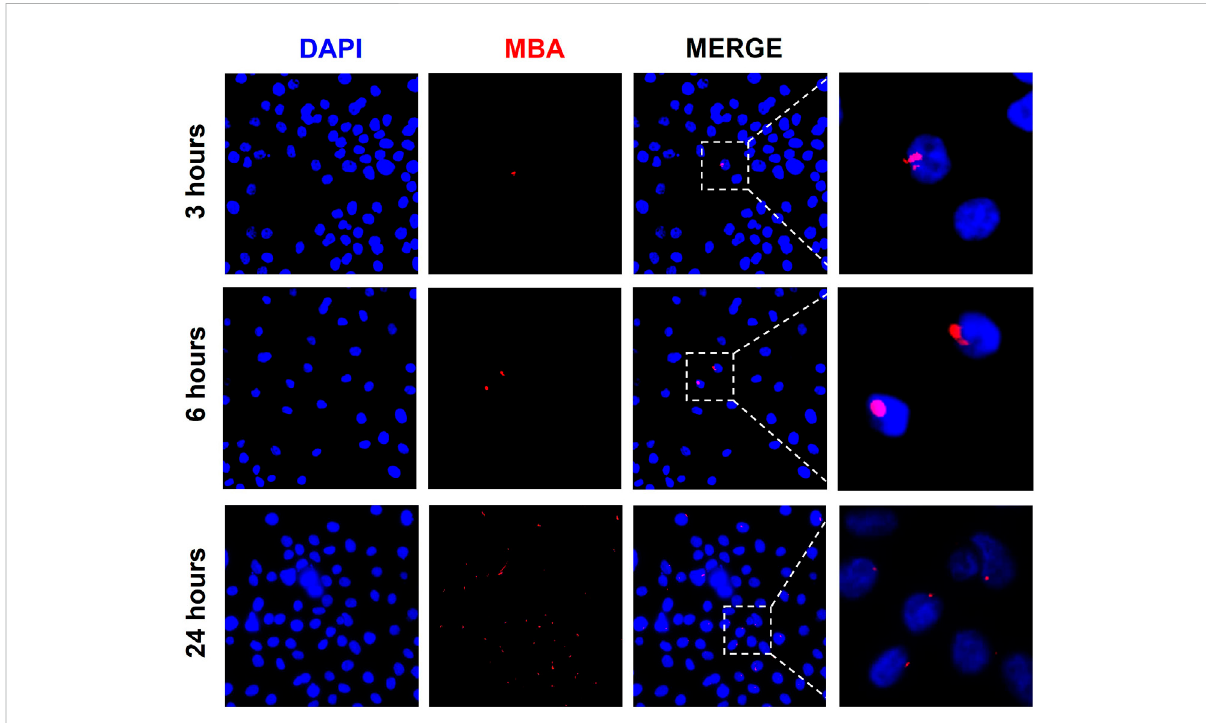
FIGURE 3 Exosomesfrom U.parvum -infectedECTOepithelialcellsdeliverMBAtoENDOcells.Immunocytochemicalstainingofmultiplebandedantigen (MBA), a lipoprotein and known virulence factor of U. parvum, in ENDO cells treated with exosomes from U. parvum -infected ectocervical epithelial cells for 3, 6, and 24 h. Red – MBA. Blue –